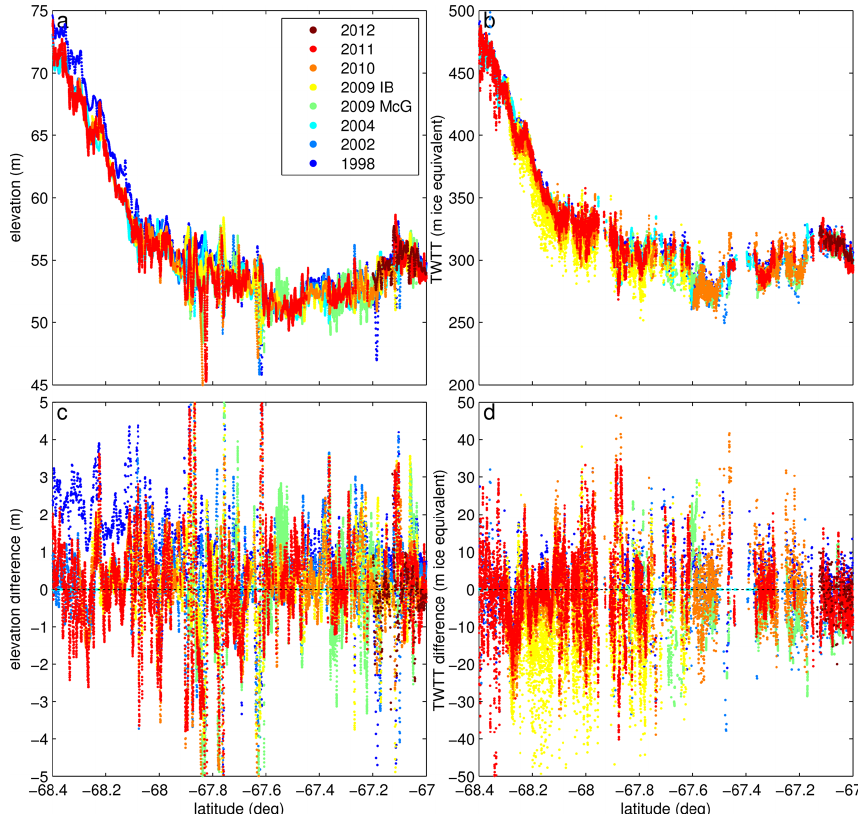
Figure 2. Processed data from the eight surveys from which the air and ice thickness changes are derived. (a) Surface elevation relative to WGS84 ellipsoid. (b) Radar two-way travel time (TWTT), expressed as an equivalent thickness of solid ice. (c) Difference between each elevation observation and nearest 2004 analogue. (d) Difference between each TWTT observation and nearest 2004